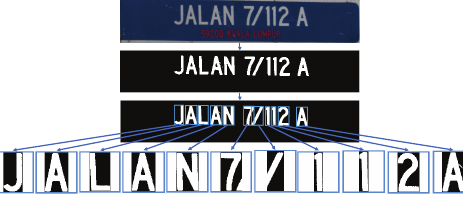
Figure 4. Extraction of text from the street